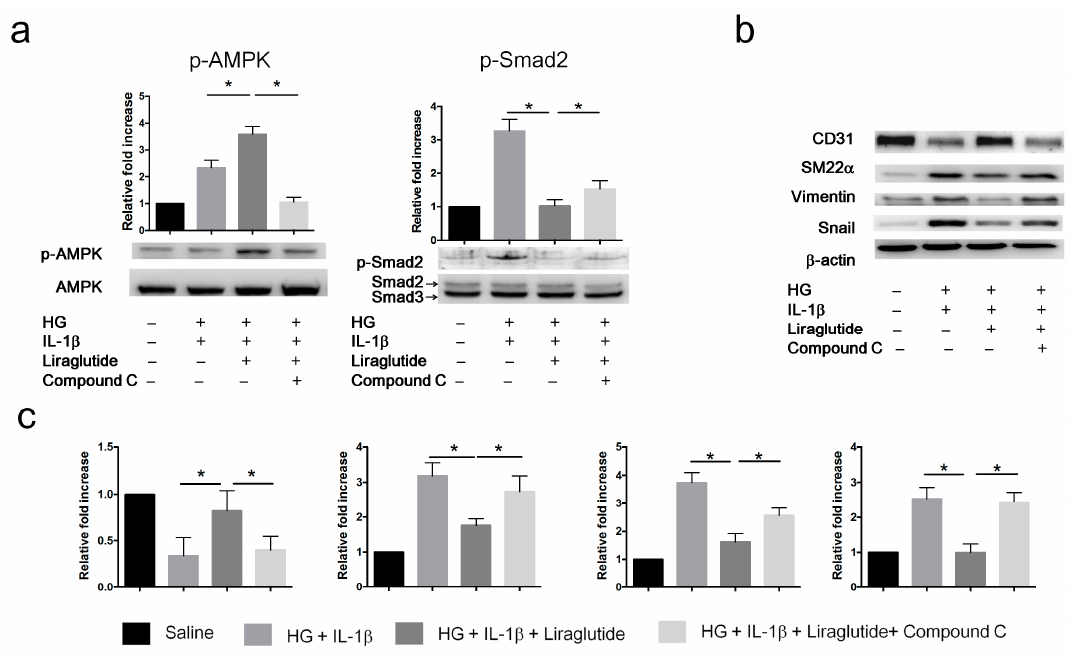
Figure 6. Liraglutide inhibits EndMT in HUVECs via the AMPK pathway. HUVECs were cultured in the following four conditions for 72 h: (1) Saline; (2) HG (30 mM glucose) plus IL-1 β ; (3) HG plus IL-1 β and Liraglutide; (4) Liraglutide and Compound C. Cell lysates were collected for western blot analyses. ( a ) Western blot analysis of the protein levels of p-AMPK α and p-Smad2. Total AMPK α and Smad2 / 3 were used as loading controls for p-AMPK and p-Smad2, respectively. ( b ) Western blot analysis of the protein levels of CD31, SM22 α , vimentin, and Snail in HUVECs treated with di ff erent conditions. B-actin was used as the loading control. ( c ) Quantification of the relative fold increase is shown as the mean ± SD from three independent experiments. * P < 0.05. The statistical significance was assessed by Kruskal–Wallis